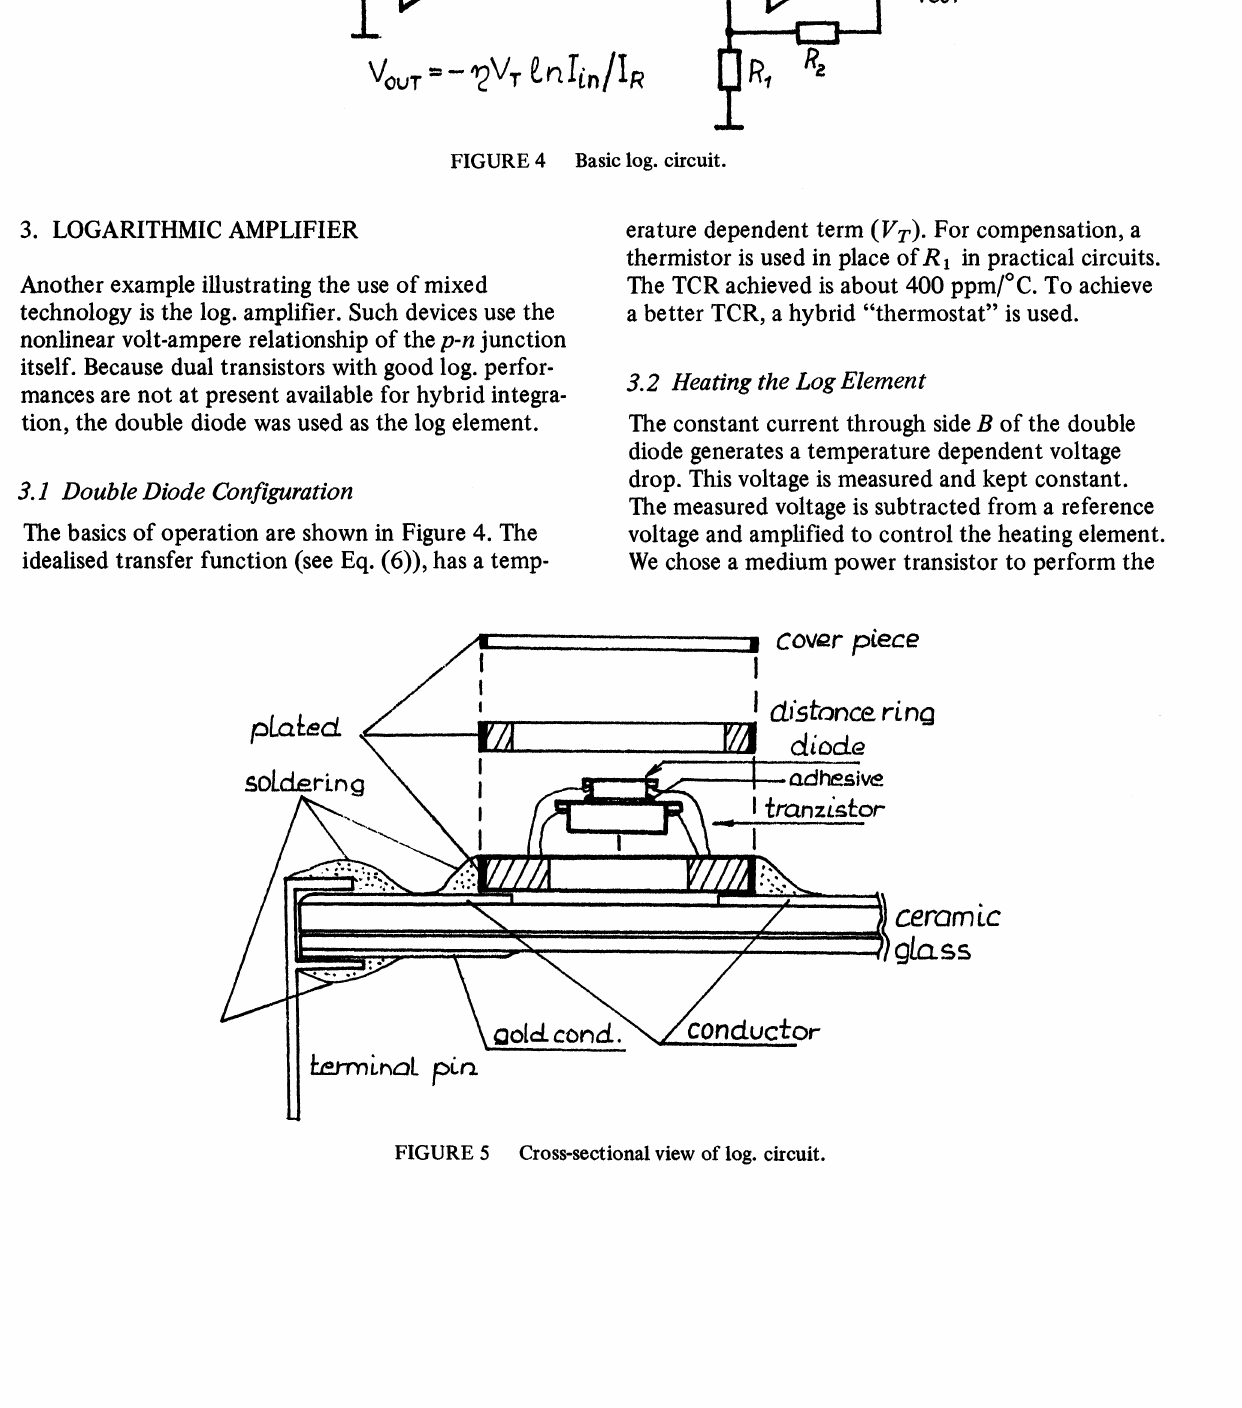
FIGURE 5 Cross-sectional view of log.